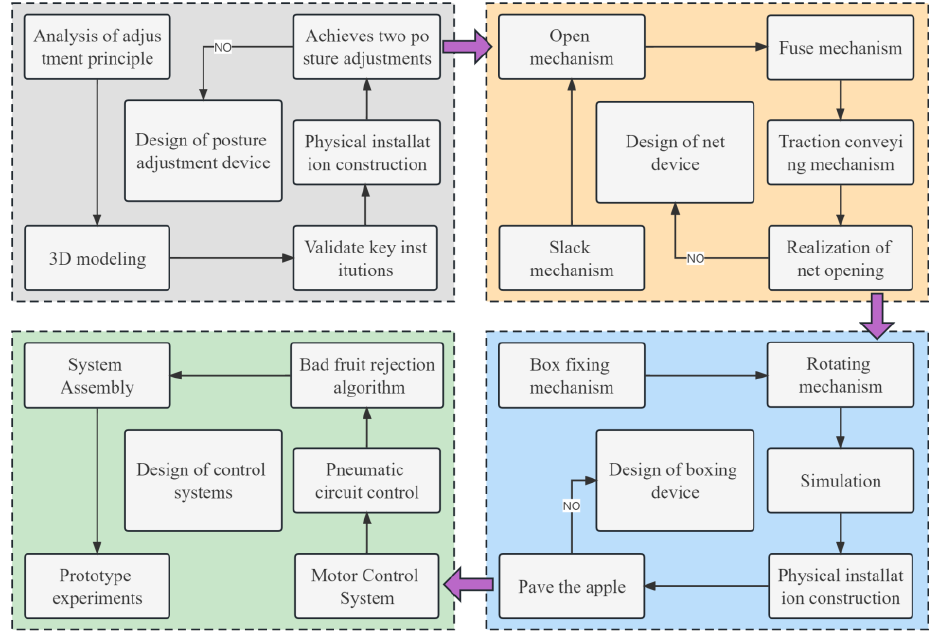
Figure 3. Machine design schematic.